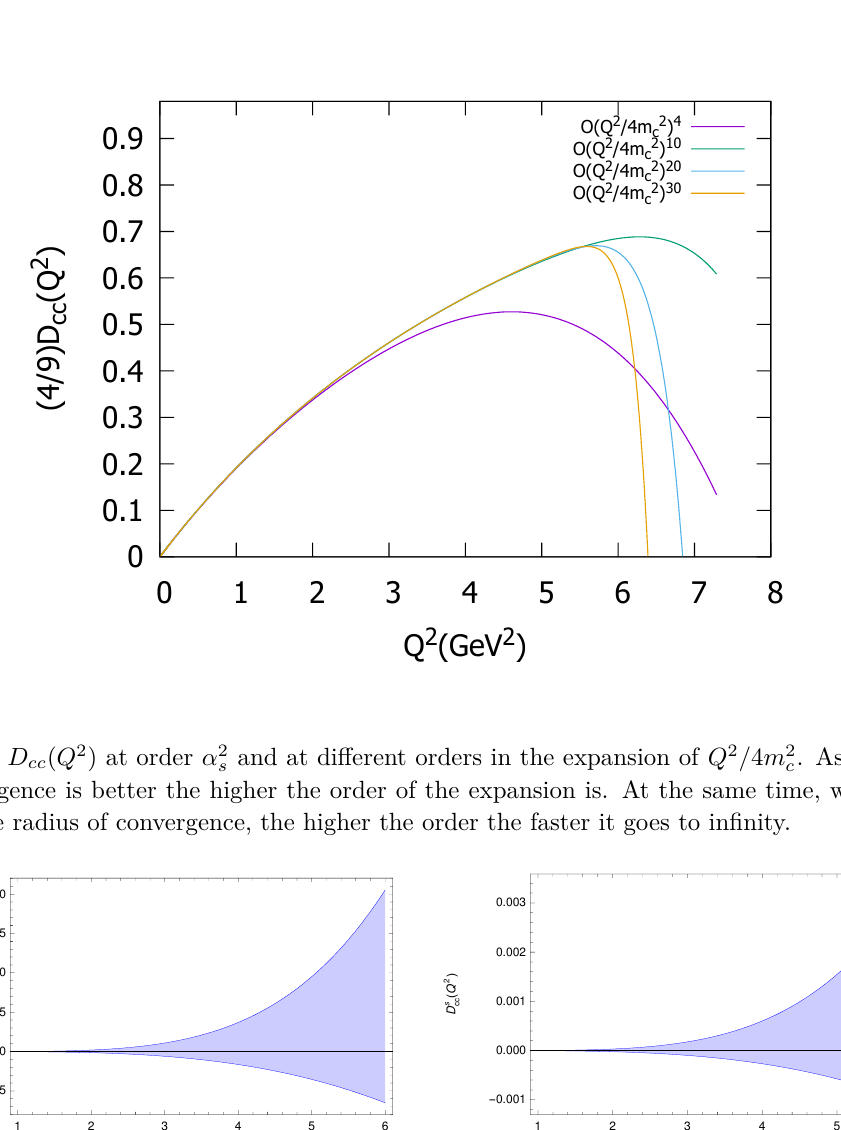
Figure 9 . Estimated value of D s